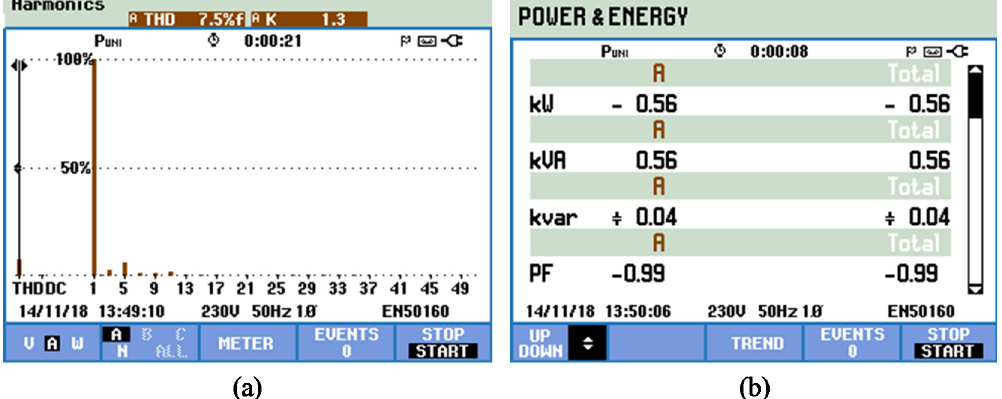
Figure 16. Experimental results during the MF-EVCS operation in V2G mode combined with the operation as APF: ( a ) Harmonic spectrum of the total home current (i g ); ( b ) Operating powers and total power factor.